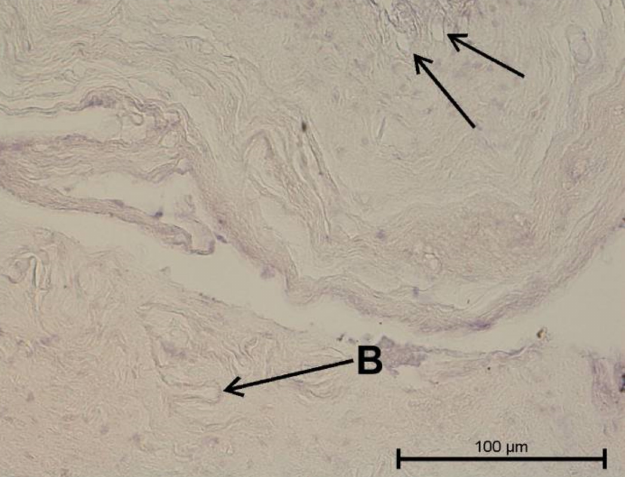
Figure 15. Light microscope image. Healthy tooth. Anti-Prox 1—negative (black arrow). B-visible newly formed blood vessels as a result of angiogenesis. Mag. 400 ×